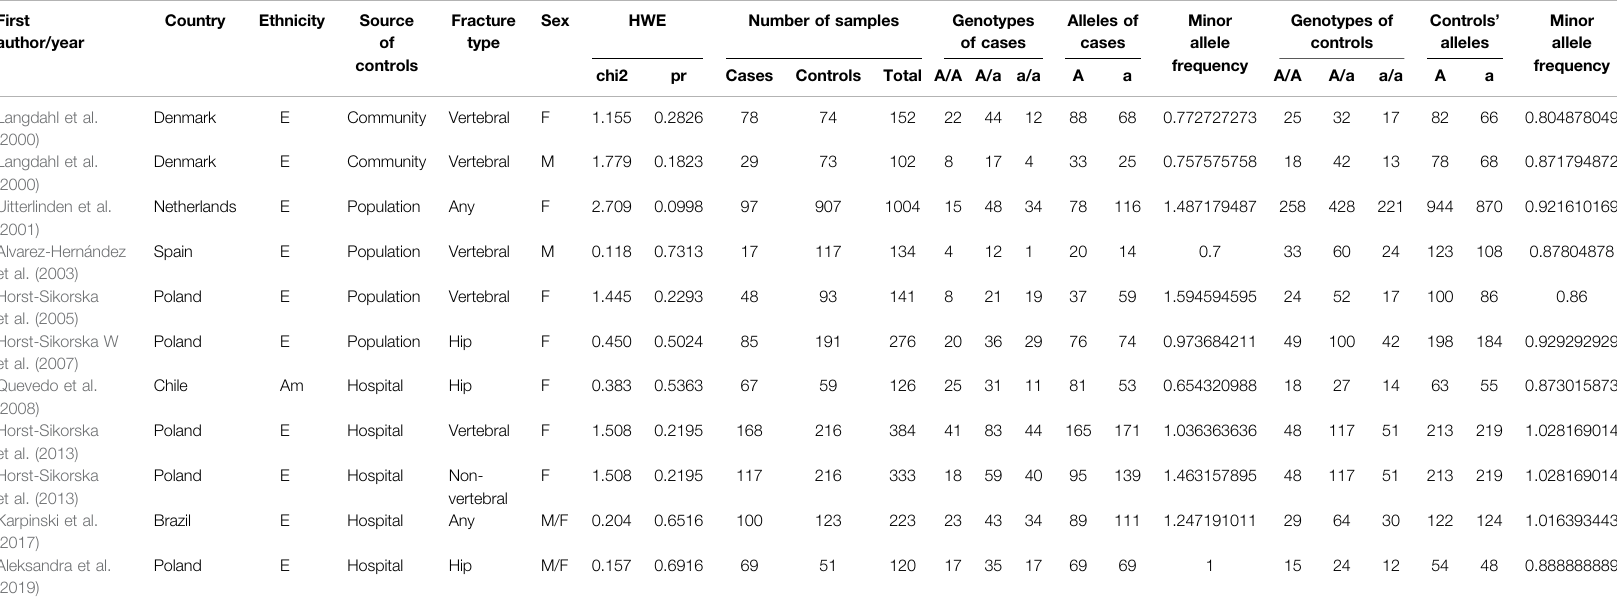
TABLE 3 | Genotype frequencies of VDR ApaI polymorphism in studies included in this